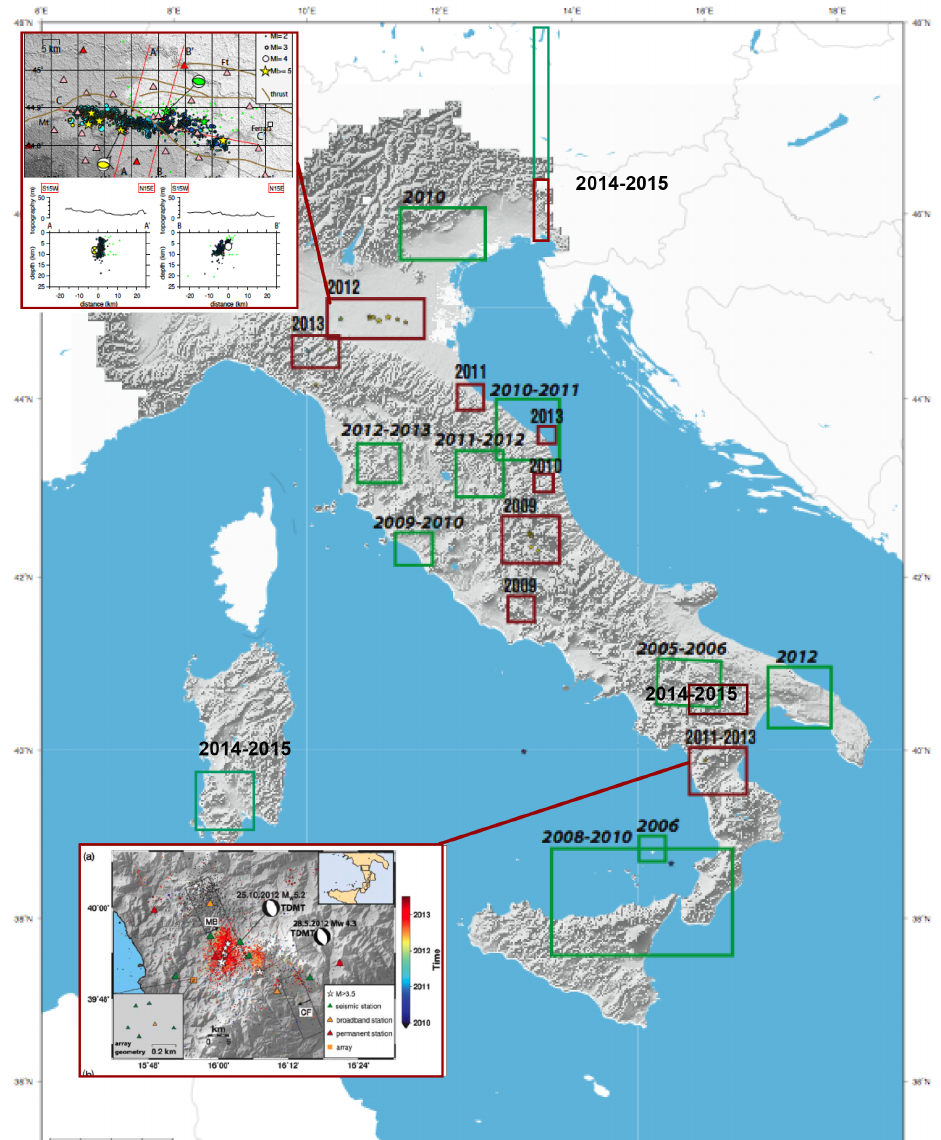
Figure 1. INGV temporary networks deployed in the last 10 years: the green rectangles represent experiment or emergency areas where only stand alone seismic stations were used, while the red rectangles are experiment or emergency areas where at least one real-time UMTS station was